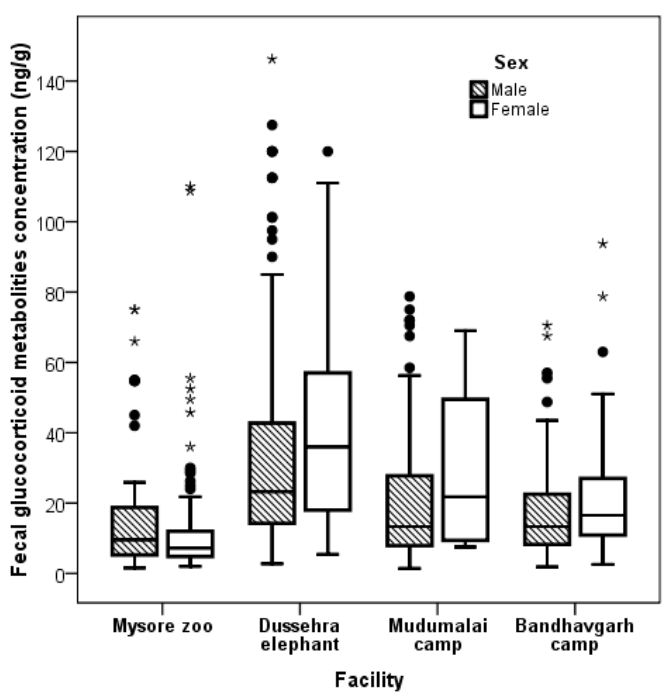
Figure 2. Box plot showing fGCM concentrations between male and female elephants in four elephant facilities (Filled rounds = outliers, filled asterisk = extreme values). In Mudumalai camp, the female’s value was from one individual.